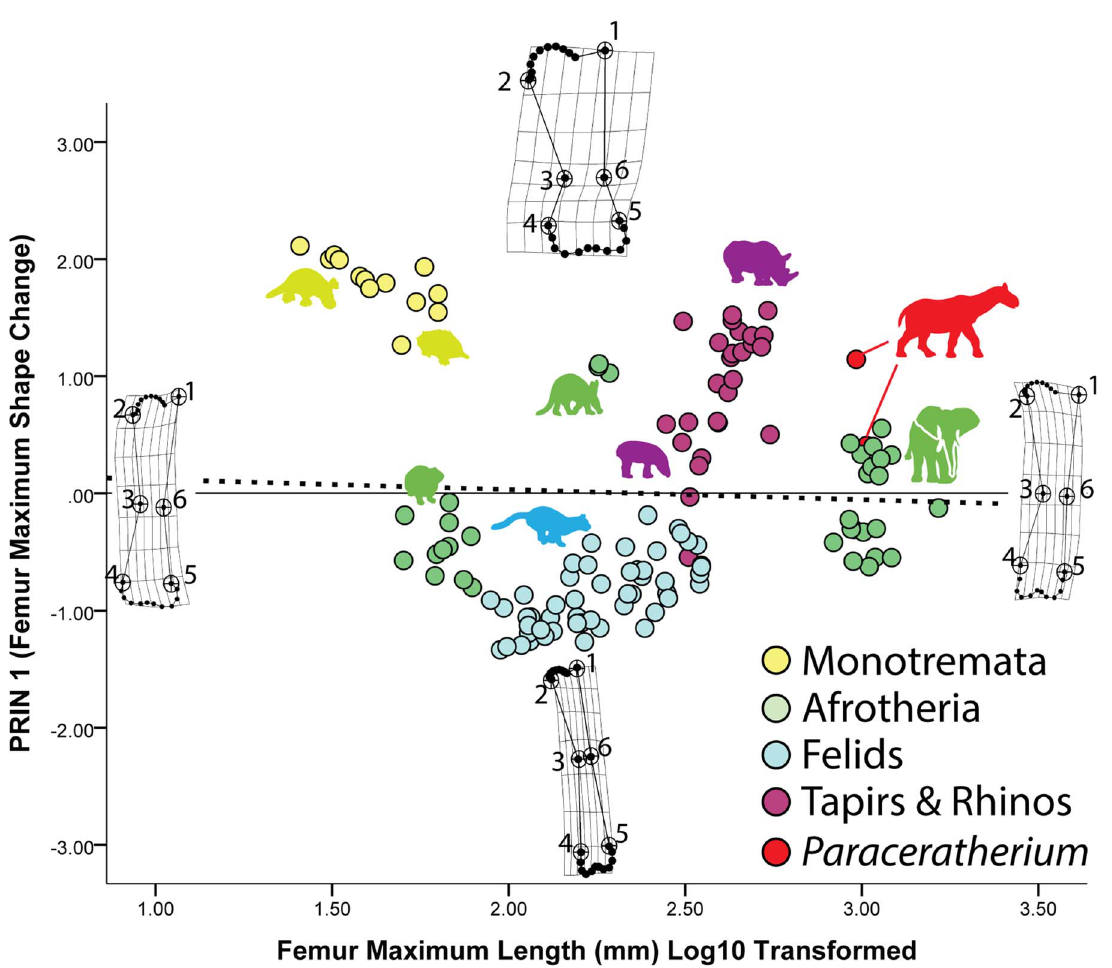
Figure 4. Changes in femur shape in mammals. Maximum femur shape change in the sample is shown on the Y-axis (PRIN 1), whereas femur shape changes associated with size are shown on the X-axis. As with the humerus, monotreme specimens plot among the most robust femora on the PRIN 1 axis, but aardvarks, rhinos, and one Paraceratherium specimen also plot in robust morphospace. Once again, the sub-articular bone region narrows significantly with increasing size and that the shapes of these regions become more defined, convex, and/or distinct. Notice also that the femoral head becomes more distinct and medially-oriented with increasing size.